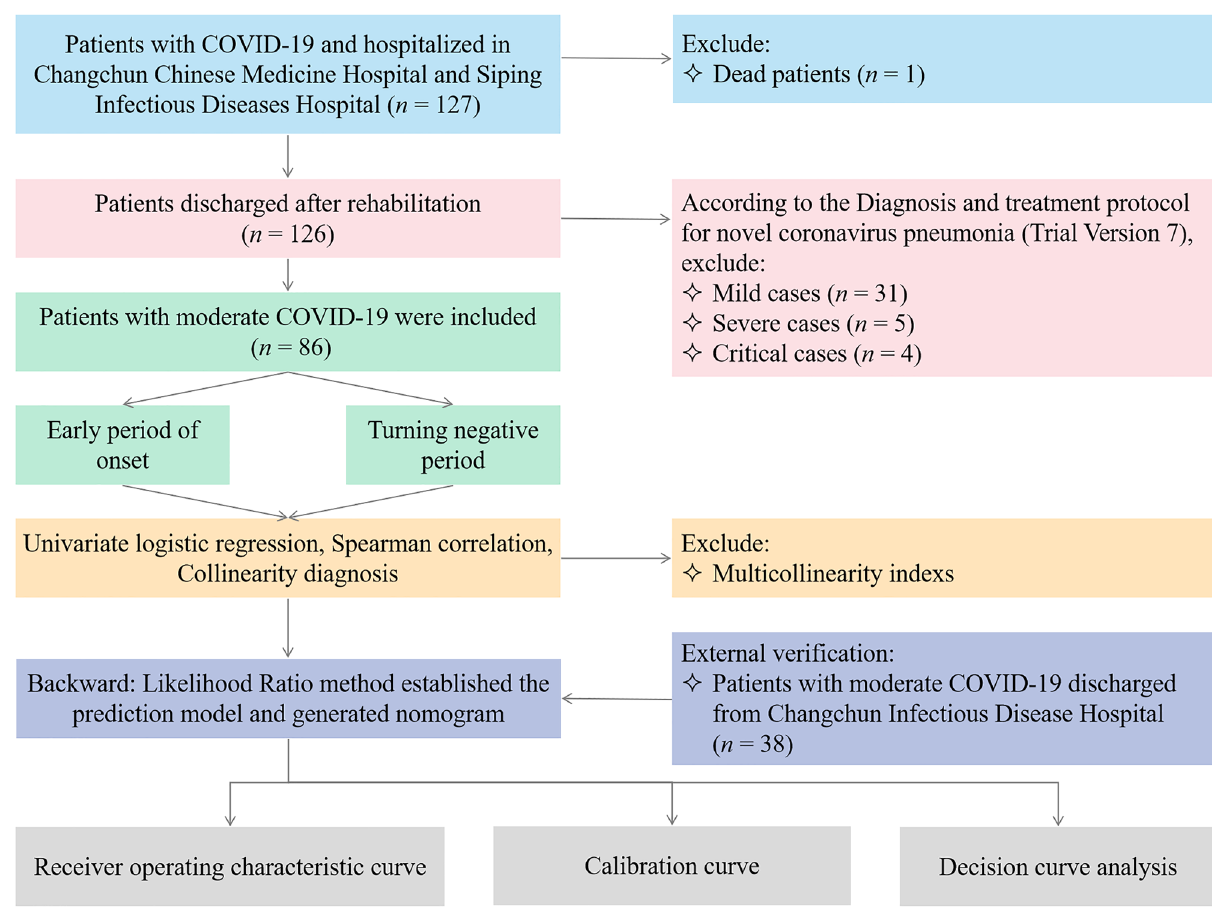
Figure 1. The flowchart of this